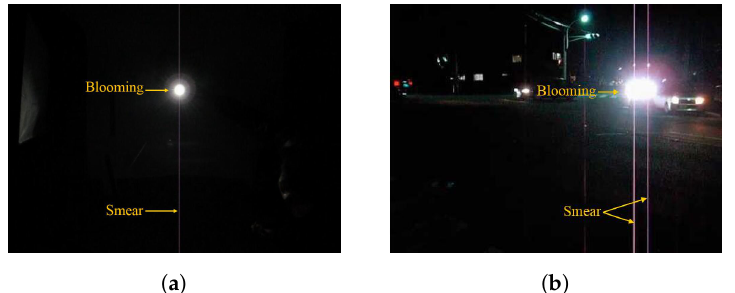
Figure 3. CCD blooming and smear. ( a ) A CCD captured image with blooming and smear, ( b ) another scene image with blooming and smear. Blooming denotes undesired bright sections surrounding the bright light source, caused by charges leaking from one pixel into adjacent pixels. Smear denotes the undesired bright sections above and below the bright light source, caused by charges’ accumulation of the light source during the vertical transfer process.